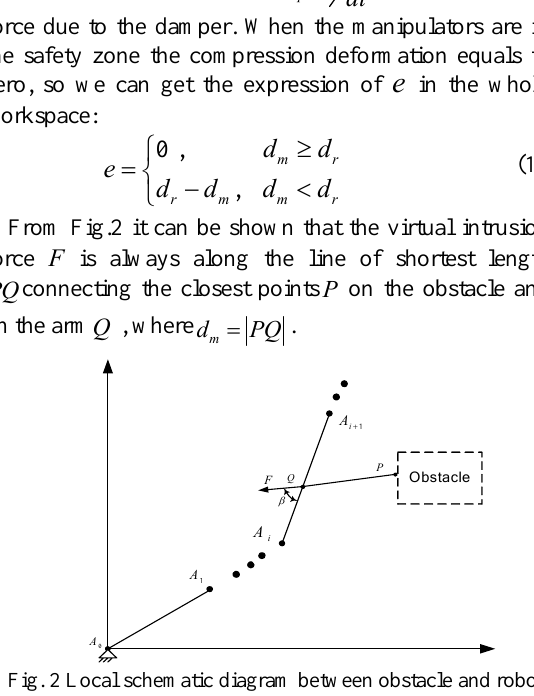
Fig. 2 Local schematic diagram between obstacle and robot